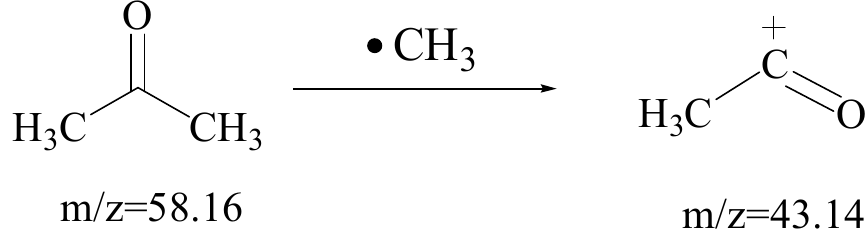
Figure 14. Degradation product of the photocatalytic degradation of gaseous acetone.